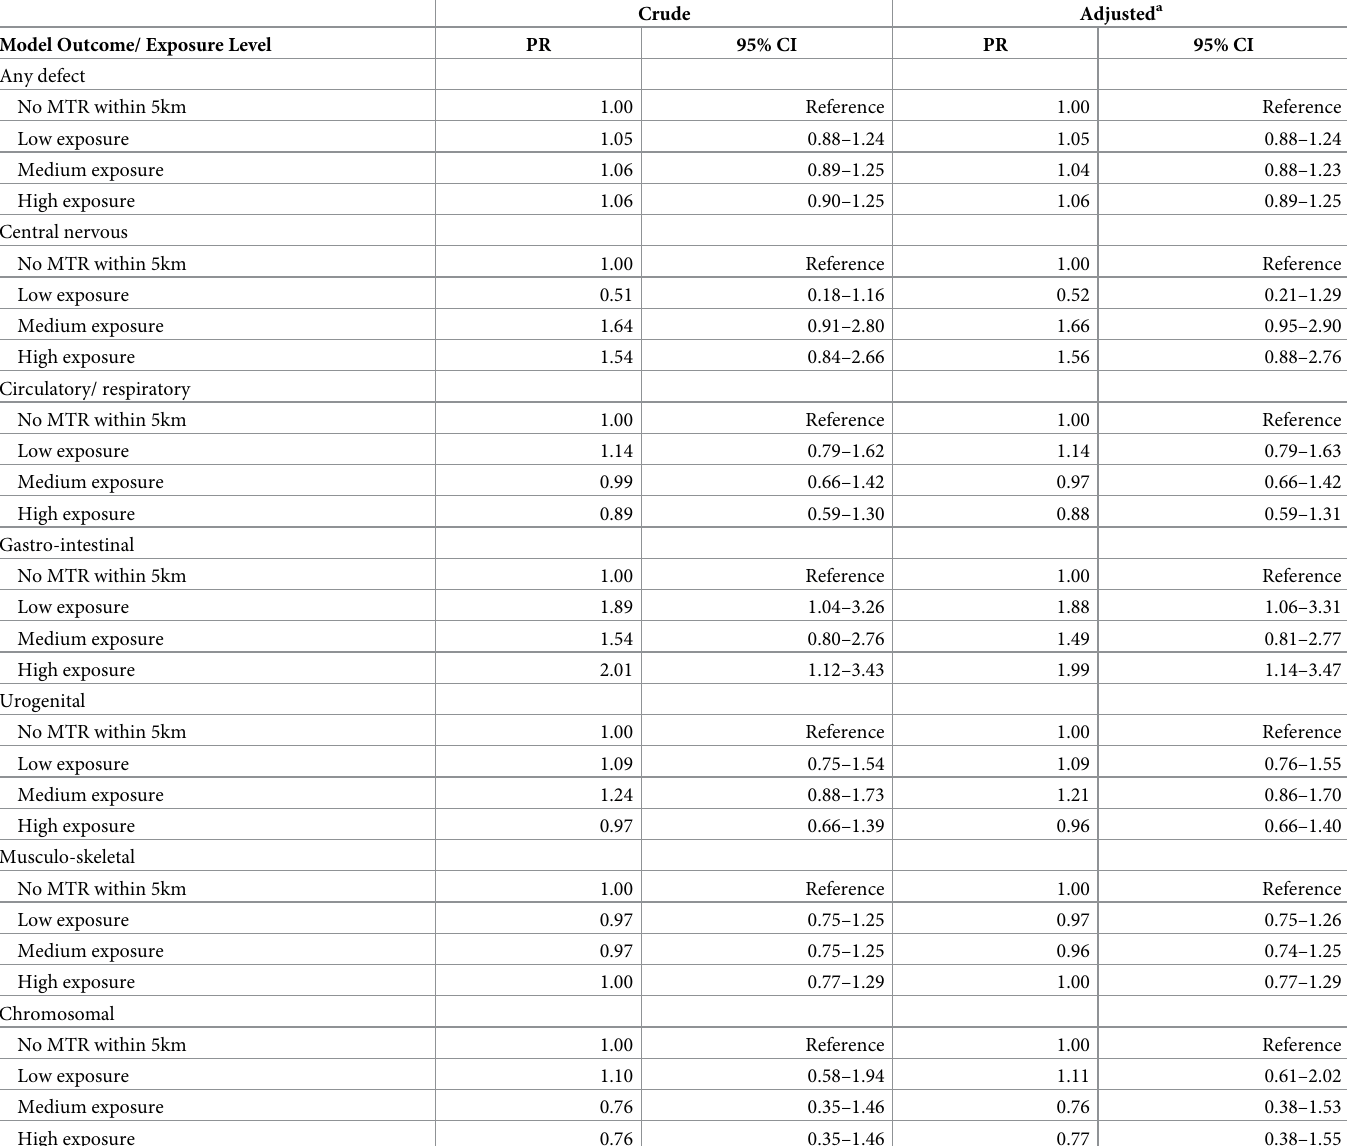
Table 3. Separate log-binomial models estimating the crude and adjusted relationship between active mountain top removal mining exposure within 5-km of maternal address and presence of a birth